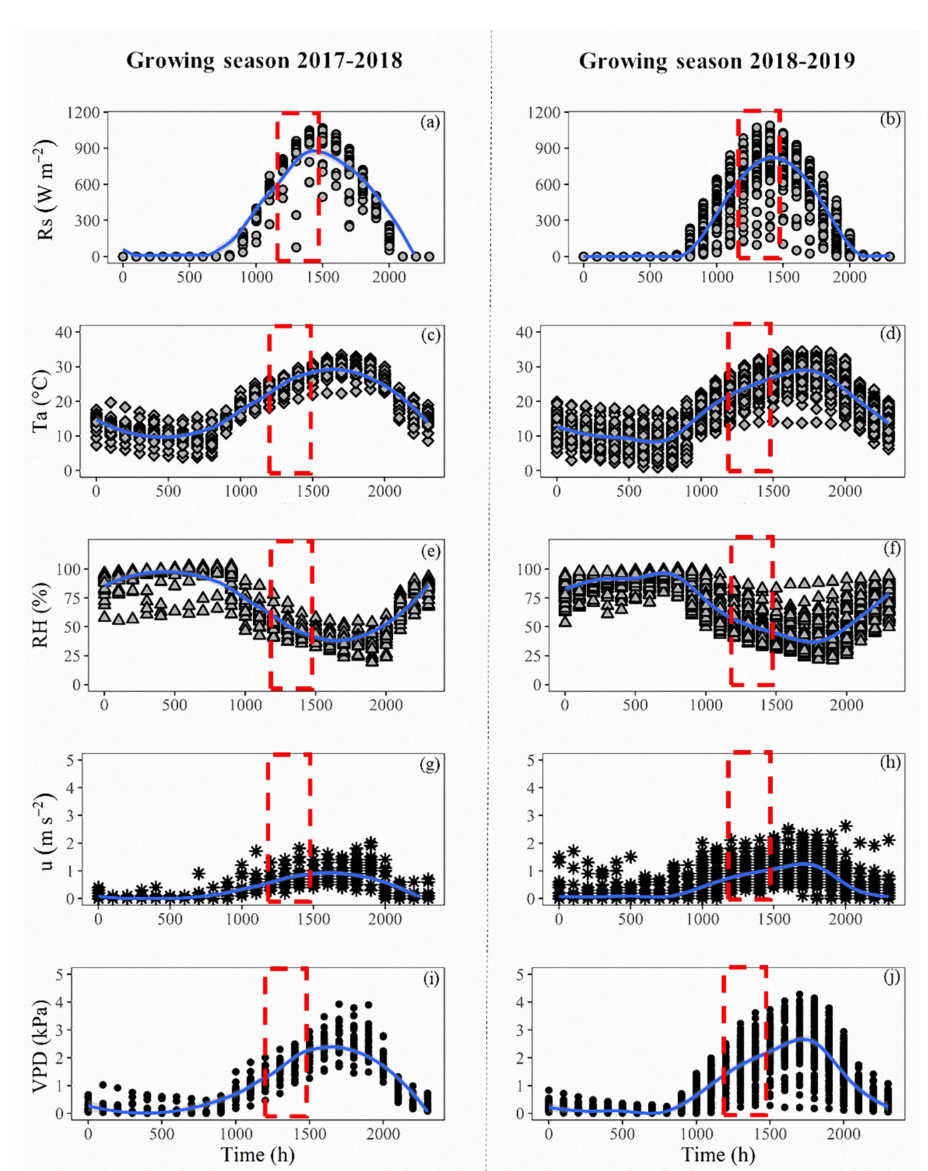
Figure 2. Post-harvest hourly variations of ( a , b ) solar radiation (Rs), ( c , d ) air temperature (Ta), ( e , f ) relative humidity (RH), ( g , h ) wind speed (u), and ( i , j ) vapor pressure deficit (VPD), inside the studied cherry trees orchard (growing seasons 2017–2018: left side, and 2018–2019: right side). The segmented red boxes denote the time of plant field measurements. Blue lines indicate the average hourly